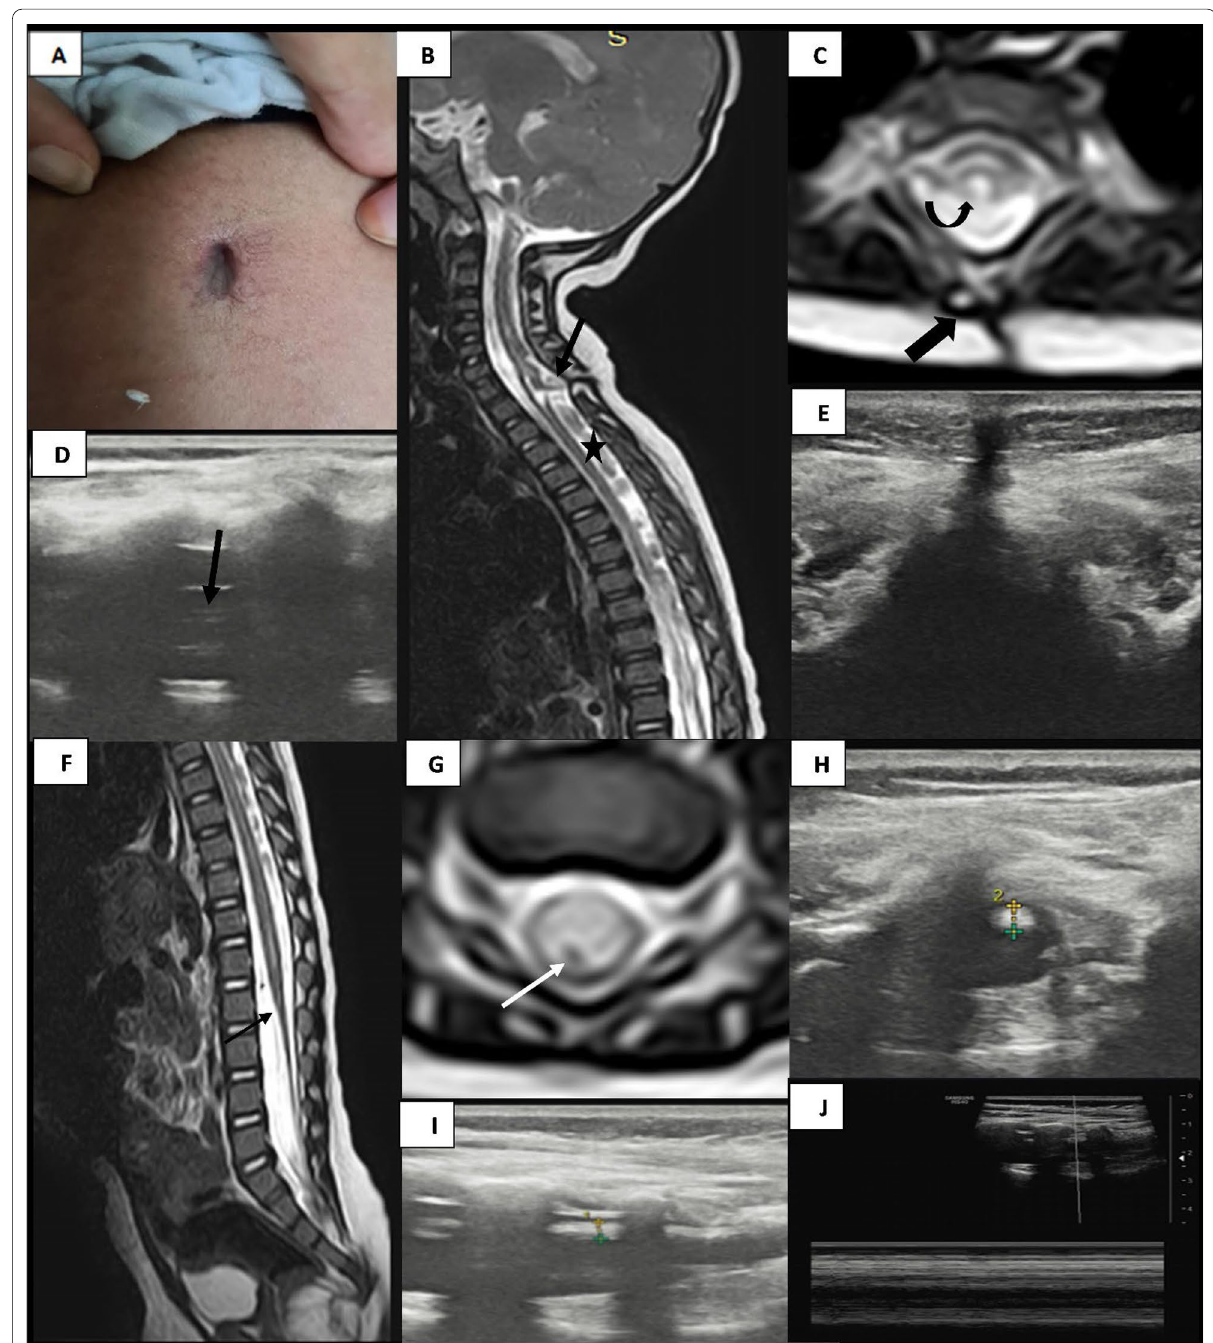
Fig. 5 Eight-month-old male infant presented with upper dorsal atypical skin dimple (crater) associated with cardiac congenital anomaly (TGA). A An upper dorsal cutaneous deep wide dimple (crater) with mild hypertrichosis. B Sagittal MRI T2WI showing fibrous tract extending from skin surface at level of D1/D2 vertebrae passing deeply into spinal canal with tethering and slight tenting of spinal cord at that level (black arrow), dorsal CSF flow artifact (star). C Axial MRI T2WI showing the fibrous tract passing though spinal bifida of D2 vertebra (black arrow) with minimal syrinx at that level (curved black arrow). D Sagittal USG image showing minimally dilated central canal (black arrow). E Axial USG image showing the fibrous tract extending from skin surface into spinal canal. F Sagittal T2WI at level of lumbar spine showing conus tip at level of L2 vertebrae (black arrow) with relatively thickened filum terminale. G Axial T2WI showing thickened filum terminale (white arrow). H , I Axial and Sagittal USG images showing thickened echogenic filum terminale measuring 2.1 mm. J M mode USG image at L5-S1 level showing absent movement of nerve roots. Type of spinal dysraphism: Dorsal LDM with focal syrinx and tight filum